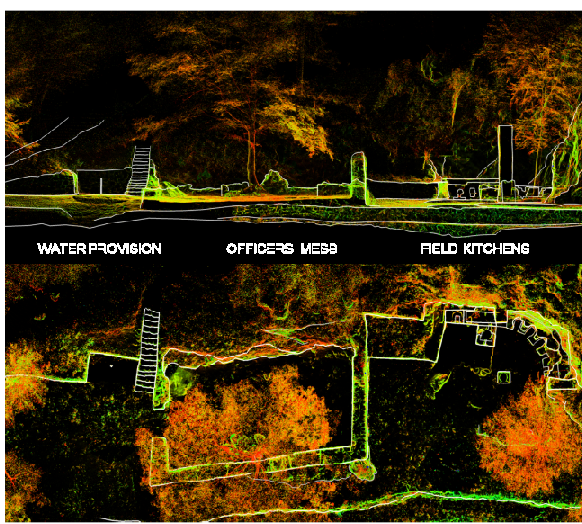
Figure 7. The kitchen area: the post-processed vegetation free data with some CAD drafts, front view (top) and top view (bottom).